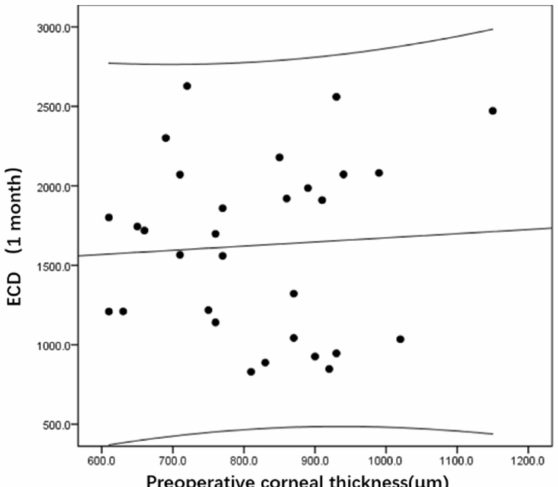
Figure 2. Clinical photographs and AS-OCT of a patient in group 2 before DSAEK ( A ) (CCT930 µ m), 1 month after DSAEK ( B ) (RCT631 µ m, GT170 µ m) and 12 months after DSAEK ( C ) (RCT600 µ m, GT148 µ m).